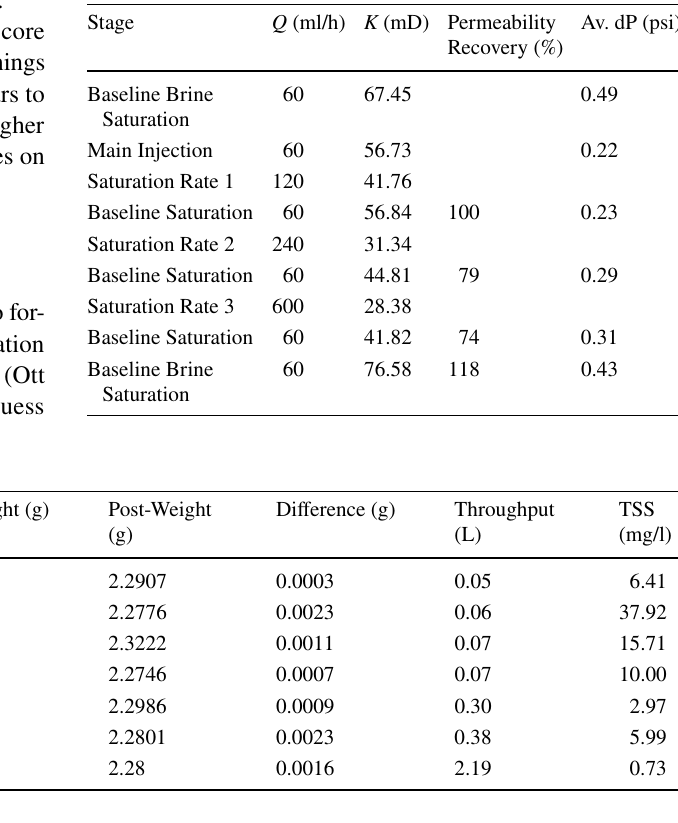
Table 13 Permeability and baseline differential pressure for